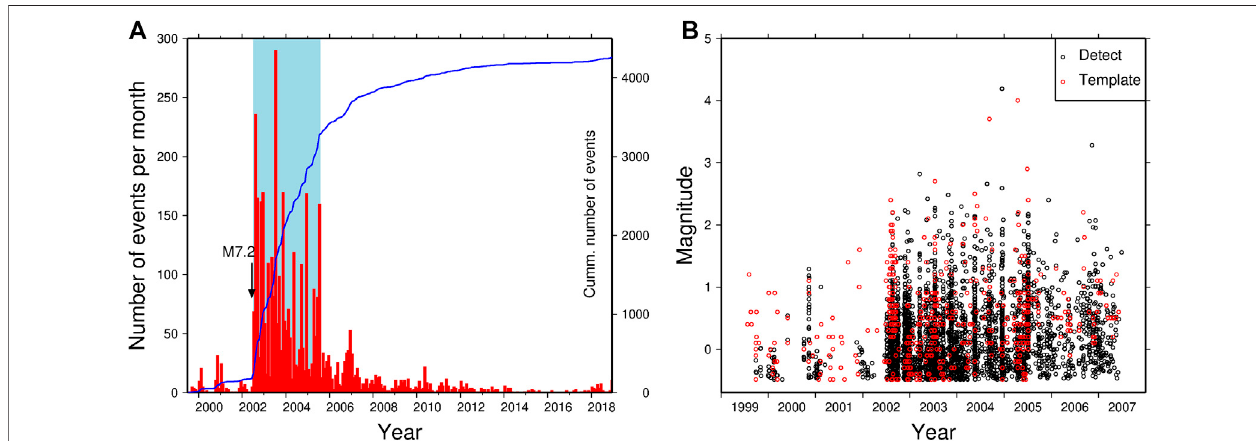
FIGURE3|(A) Monthlyratesofseismicitylistedinthejointcatalogue(redbars)from1999to2018aroundChangbaishan volcano.Thejointcatalogueisproduced by merging two catalogues. The fi rst is the automatically detected catalogue from Jul. 1999 to Jul. 2007 in this study, and the second one is manually picked catalogue from Aug. 2007 to Dec. 2018. The light blue shaded area indicates the time period of volcanic unrest. The blue curve represents the cumulative number of events. (B) Template events (red circles) and detected events (black circles) listed in the automatically detected catalogue.